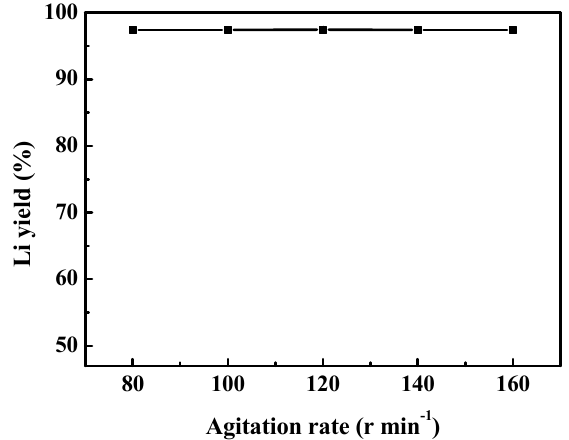
Figure 10. E ff ect of agitation rate on the extraction of lithium. Figure 10. Effect of agitation rate on the extraction of lithium.